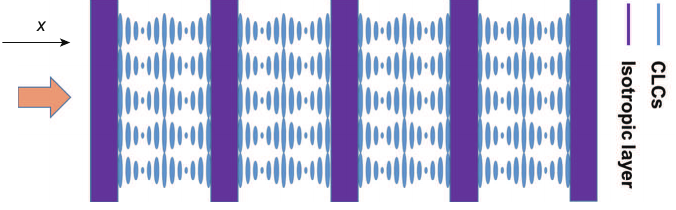
Figure 1. Sketch of the MDL-CLC structure.